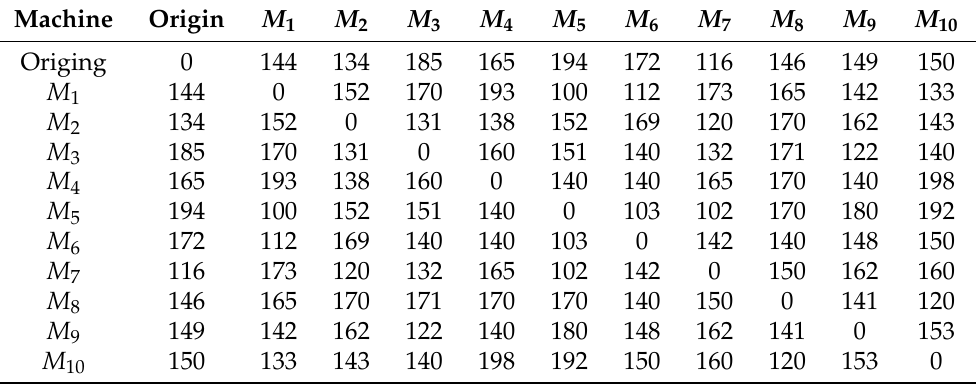
Table 6. The transport time between machines (unit: s).